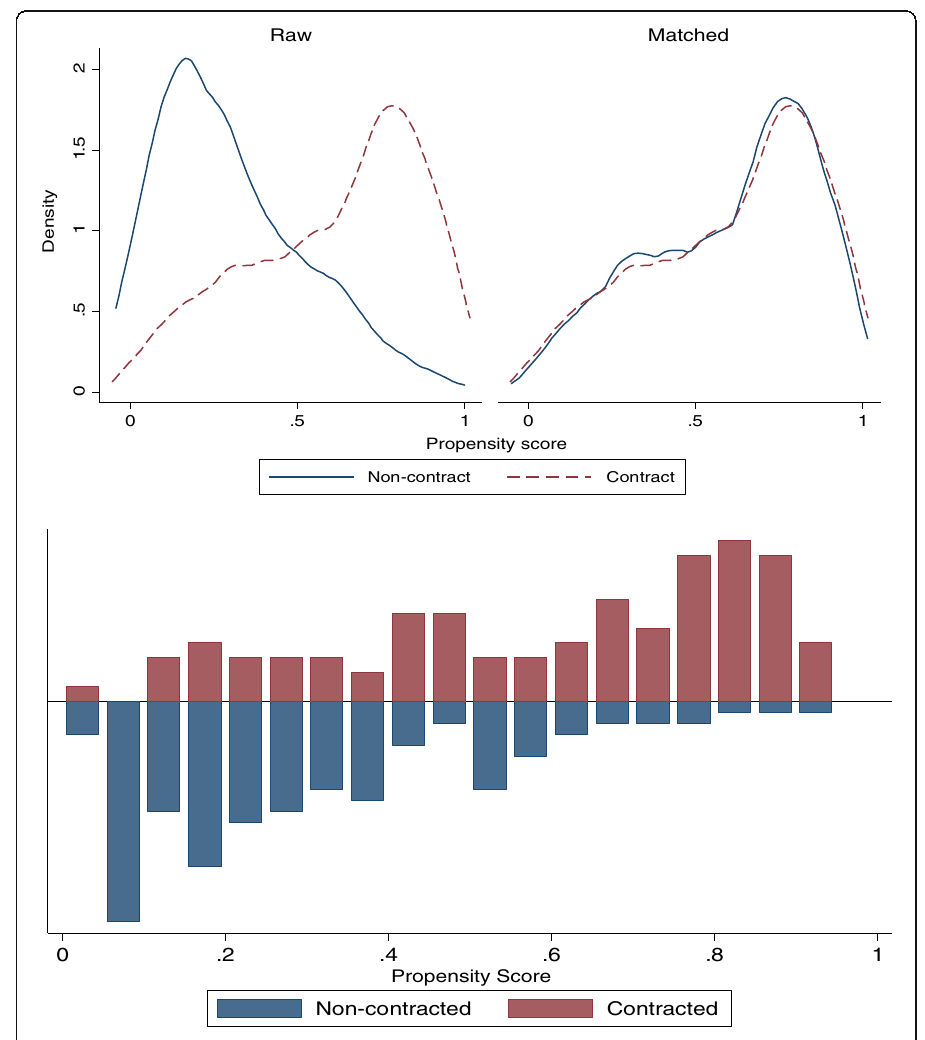
Fig. 2 Propensity score distribution and common support (before and after